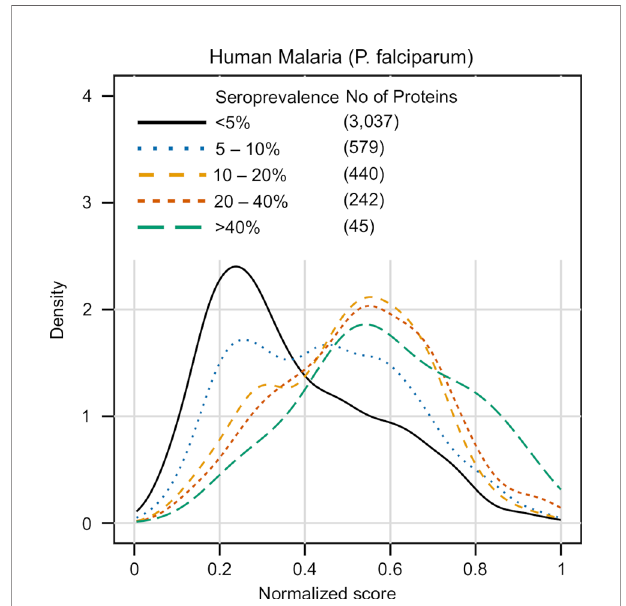
FIGURE 6 | Validation of APRANK against antigens with known seroprevalence. Detailed information on the seroprevalence of Plasmodium falciparum proteins in cases of Human Malaria was obtained from (50) (n = 38). Proteins were clustered in different seroprevalence groups and matched against APRANK antigenicity scores (see Results